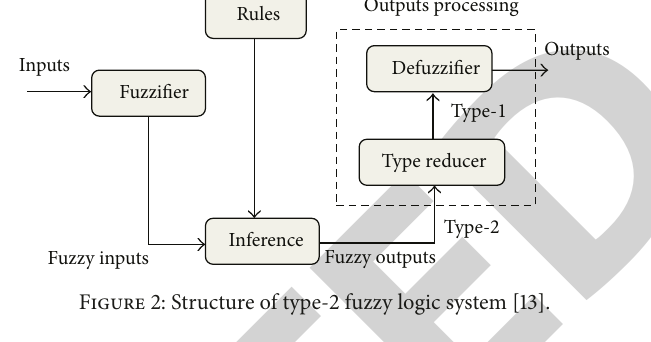
Figure 2: Structure of type-2 fuzzy logic system